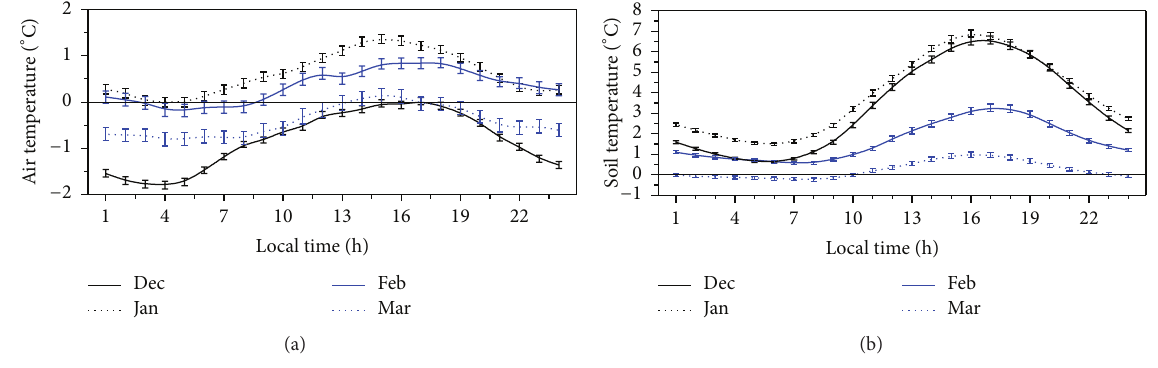
Figure 4: Diurnal variation of hourly average of (a) air temperature and (b) soil temperature for December 2013 to March 2014. The vertical bars indicate the standard error.